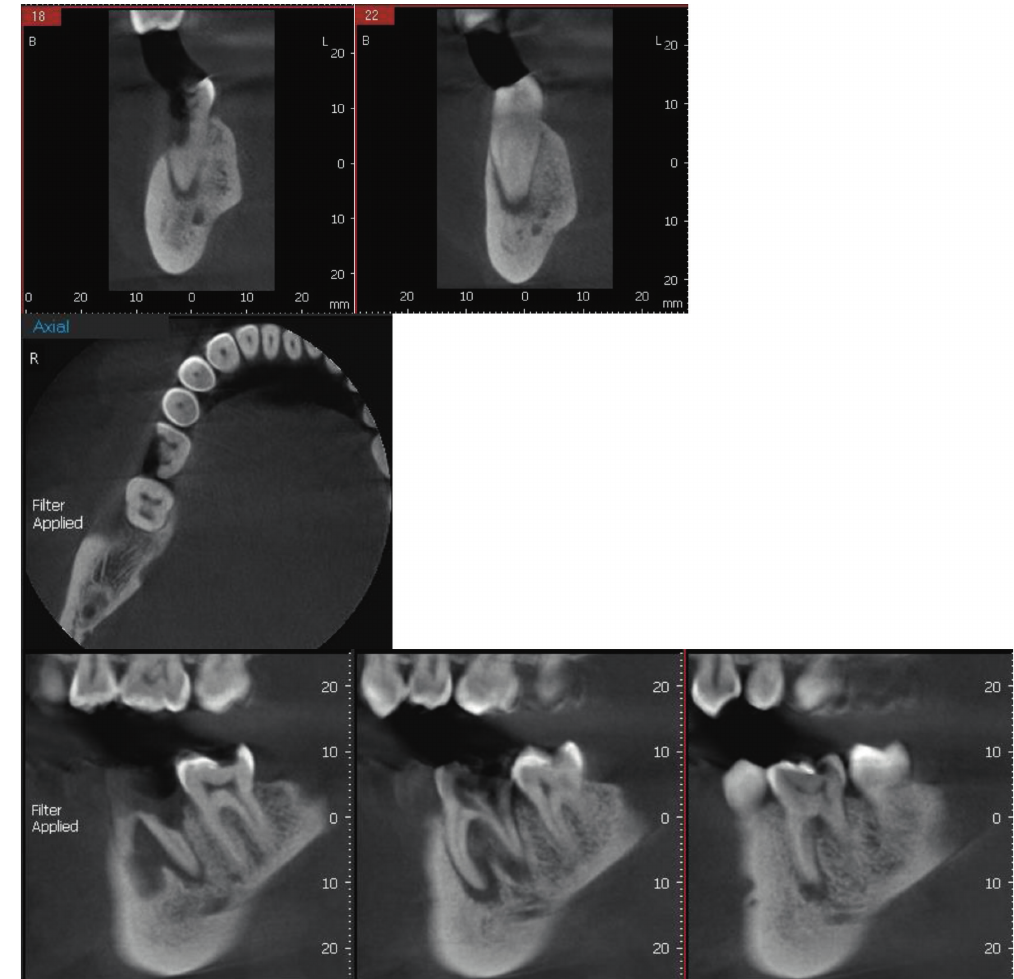
Figure 6: CBCT scanning